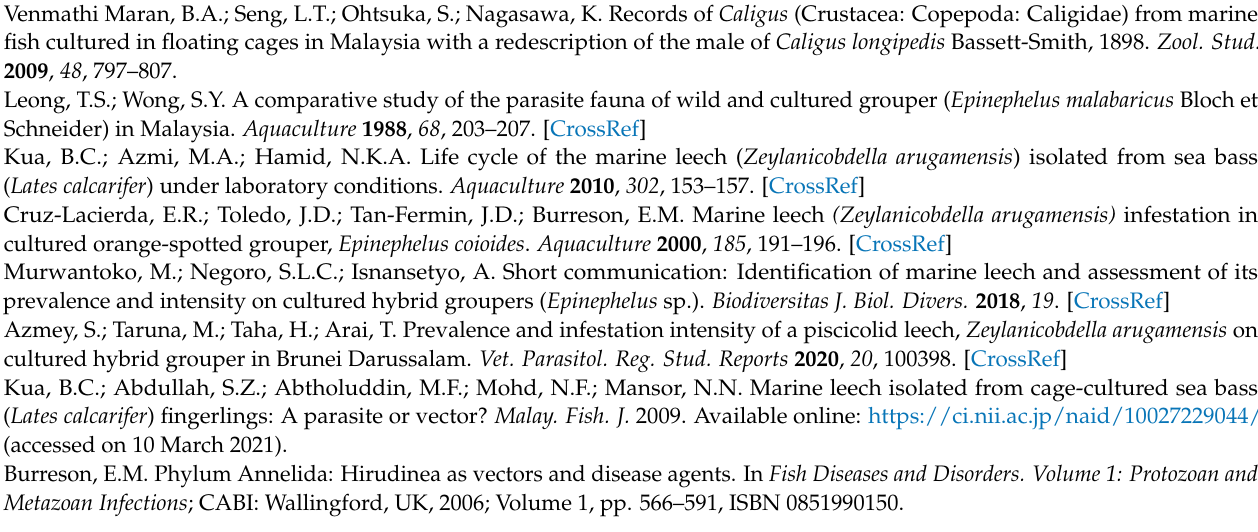
Supplementary Materials: The following are available online, Figure S1: Structures of the identified Figure S2: Base peak chromatogram (BPC) of the aqueous extract of Azadirachta indica